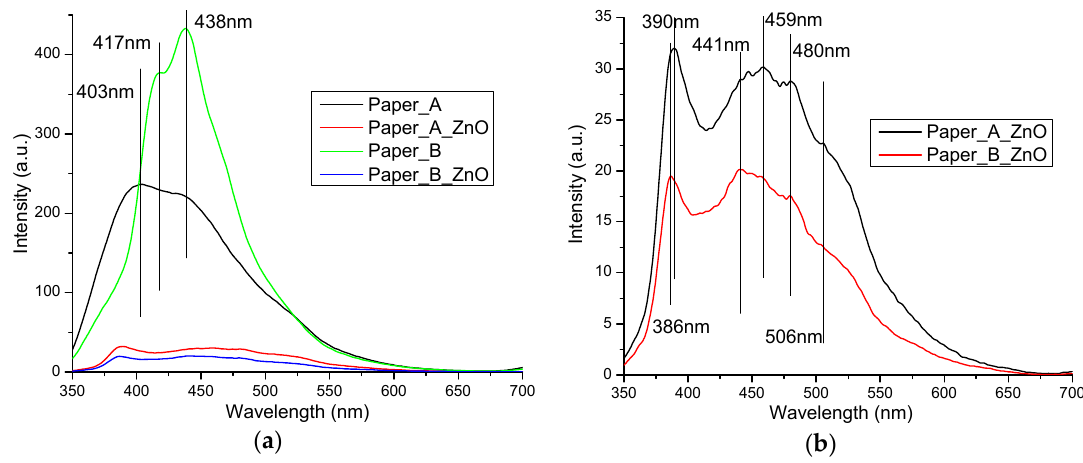
Figure 13. Photoluminescence spectra for paper samples before and after ZnO treatment ( a ); details of fluorescence spectra for ZnO treated paper ( b ).